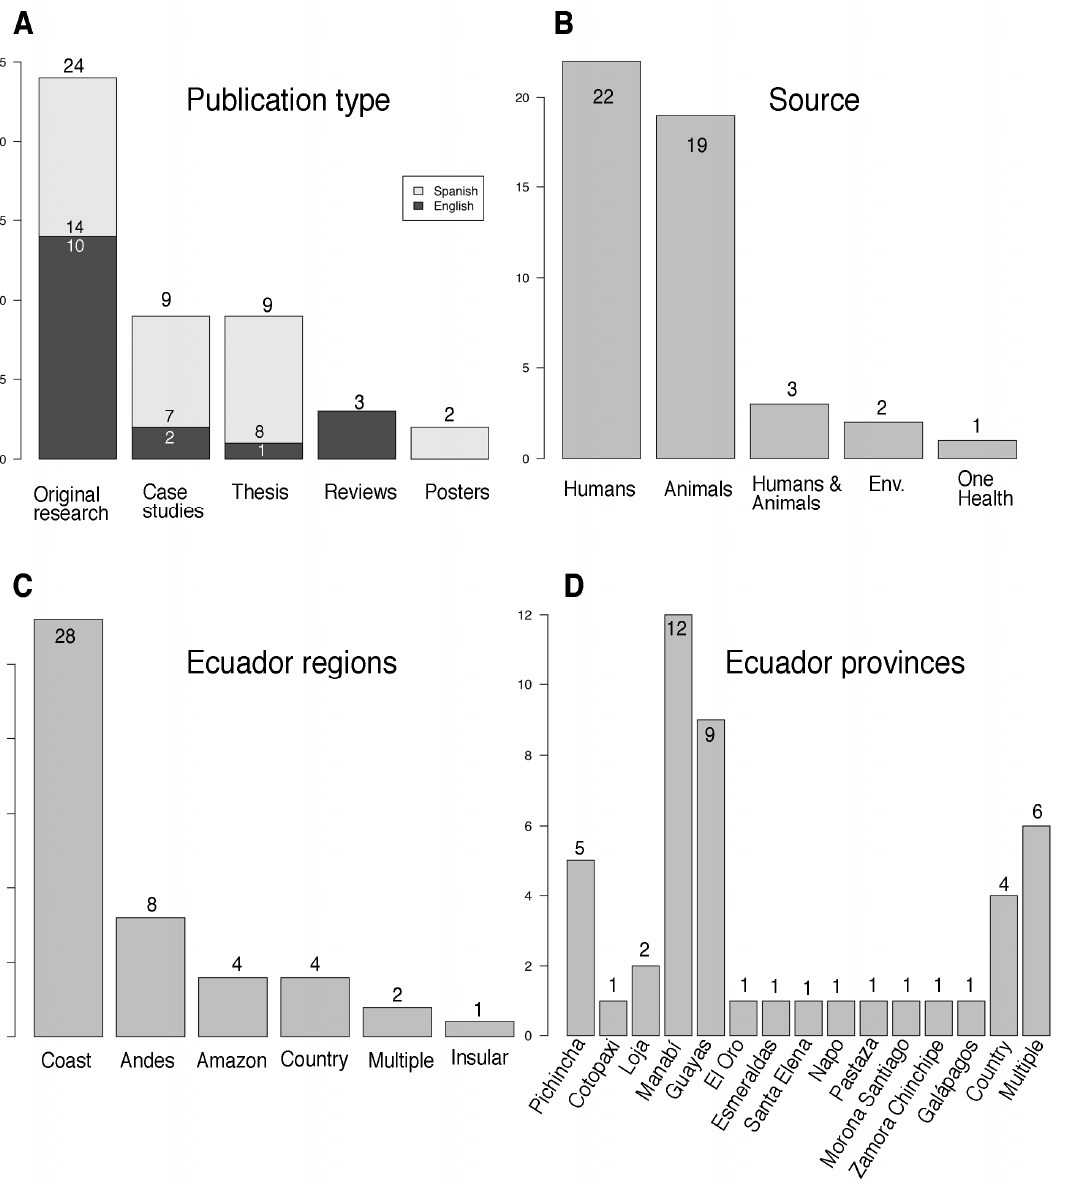
Figure 2. Statistics of the 47 publications on leptospirosis in Ecuador. In ( A ) publication types, in English (black bars) or in Spanish (grey bars); in ( B ) sources of the samples analyzed; in ( C ) by regions; in ( D ) by provinces. “One Health” refers to studies analyzing different Leptospira matrices at the same time. “Multiple” refers to studies performed in different regions and provinces at the same time. “Country” refers to studies throughout Ecuador. “Case studies” include both case reports and case series. See Table 1 for